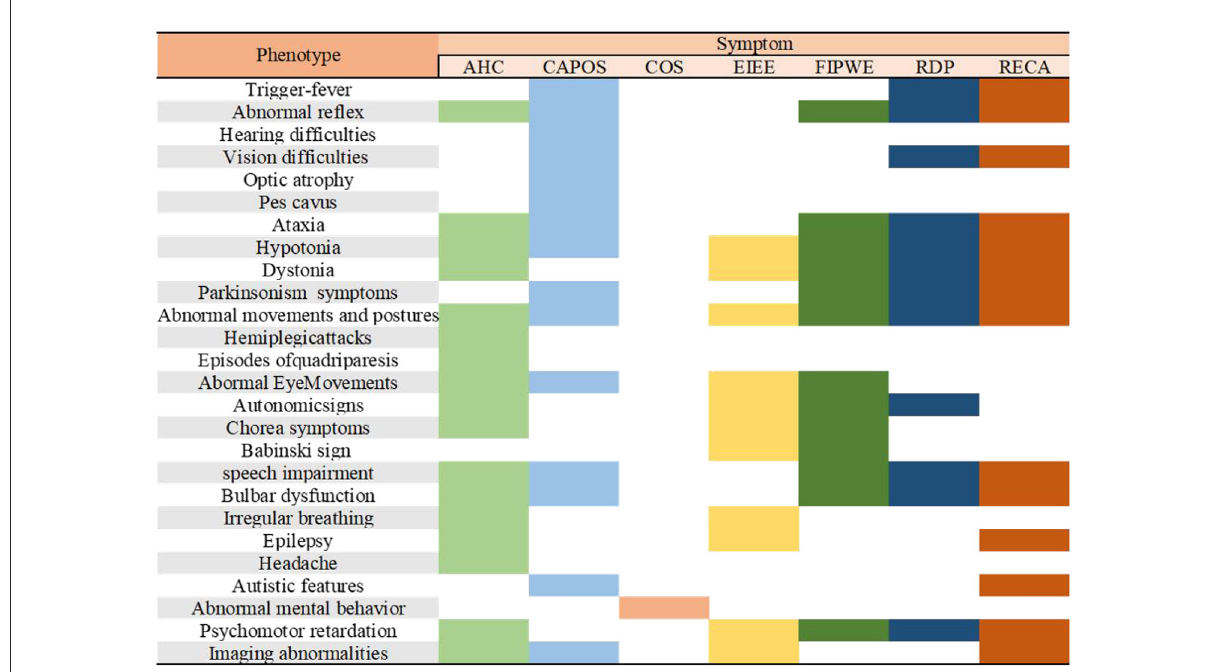
FIGURE1 Characterization of the major phenotypes associated with ATP1A3 mutations. AHC, alternating hemiplegia of childhood; CAPOS, cerebellar ataxia, areflexia, pes cavus, optic atrophy, and sensorineural hearing loss syndrome; epilepsy; COS, childhood-onset schizophrenia; EIEE, early infantile epileptic encephalopathy; FIPWE, fever-induced paroxysmal weakness and encephalopathy; RDP, rapid-onset dystonia-parkinsonism; RECA, relapsing encephalopathy with cerebellar